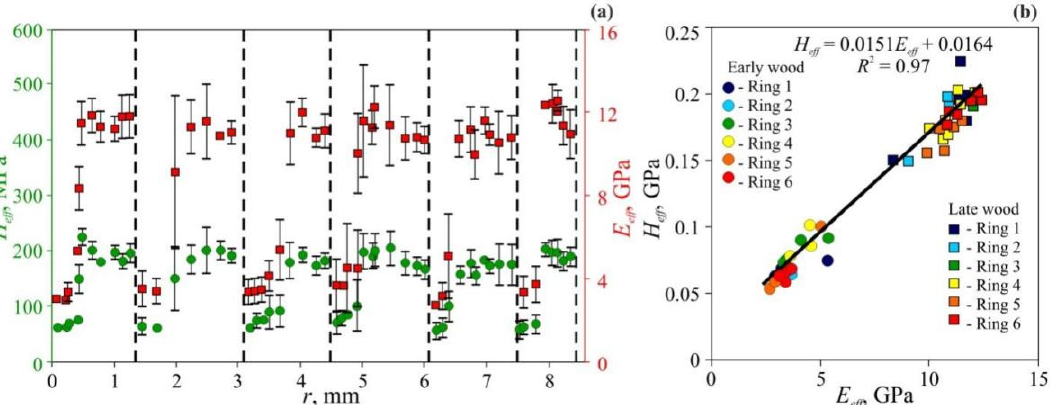
Figure 11. Micromechanical properties of pedunculate oak annual growth rings measured at P max = 500 mN [116]. ( a ) Spatial dependencies of H eff and E eff over radial distance r for six successive rings. Ring boundaries are shown using dashed lines. ( b ) Dependence of hardness H eff upon Young modulus E eff for six successive rings.